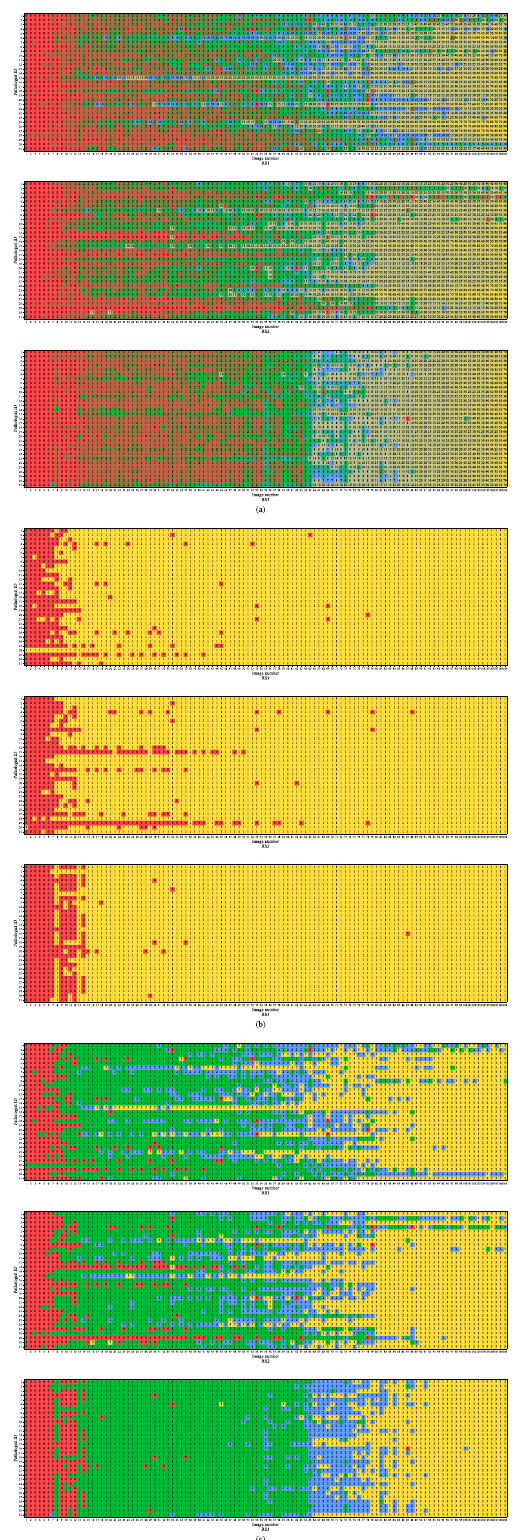
Fig. 1 Full IC score from 31 pathologists for 109 images in three- ring studies. a Continuous score. b 2-category score. The colors red and yellow represent the category scores 1 and 2, respectively. c 4- category score. The colors red, green, blue, and yellow represent the category scores 1, 2, 3, and 4,